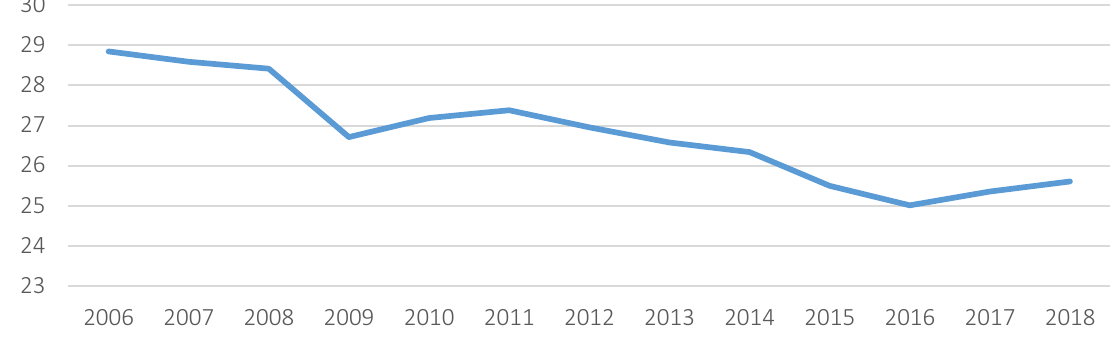
Figure 1. Evolution of industrial value-added (%